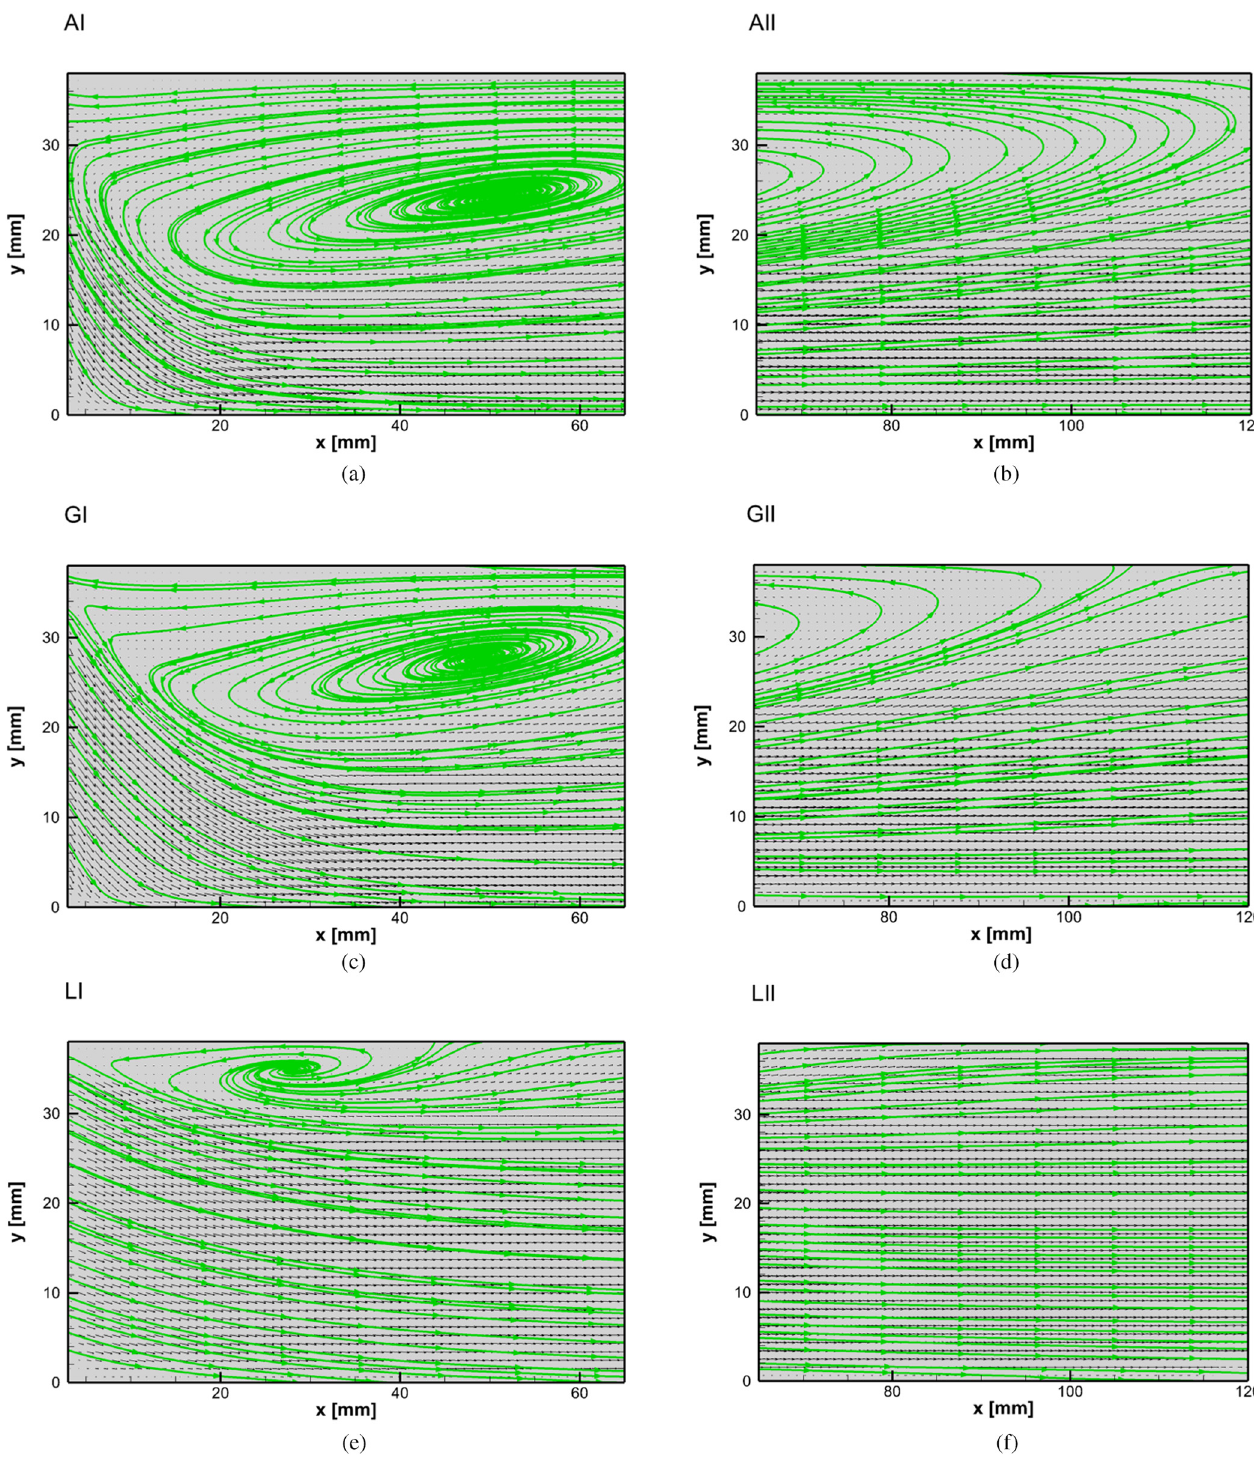
Fig. 4. Mean velocity vector fi elds in the branches A, G and L respectively: (a) AI, (b) AII, (c) GI, (d) GII, (e) LI and (f)